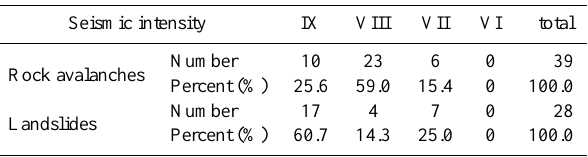
Table 6. Distribution of landslides by seismic intensity (from Insti- tute of Geography of Sichuan